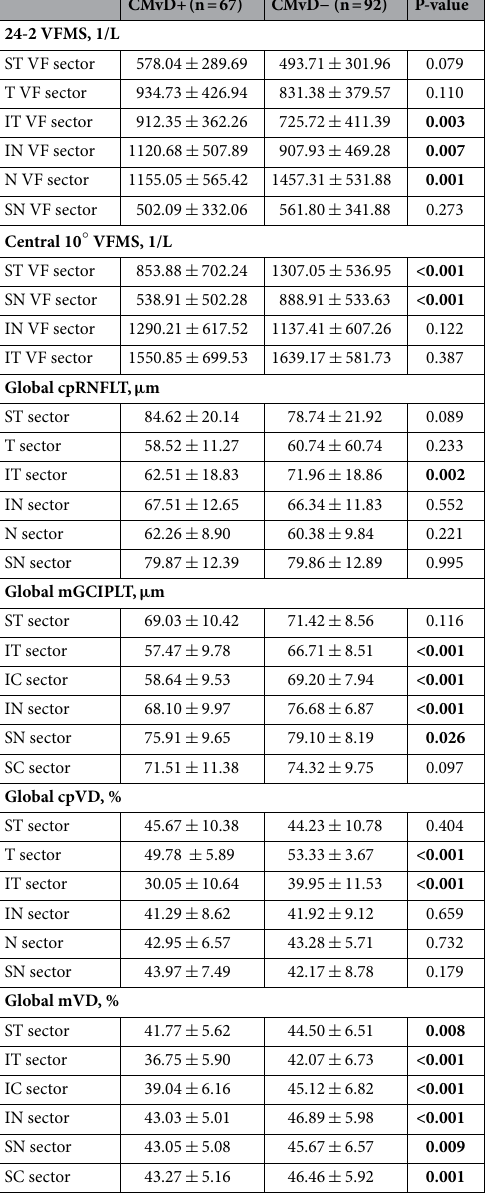
Table 2. Sectoral quantitative comparison of OCT/OCT-A and VFMS data between open-angle glaucoma eyes with and without choroidal microvasculature dropout. CMvD choroidal microvasculature dropout, layer thickness, MS mean sensitivity, mVD macular vessel density, N nasal, OCT optical coherence tomography, OCT-A optical coherence tomography angiography, SC superocenter, SN superonasal, ST superotemporal, T temporal, VF visual field, VFMS visual field mean sensitivity. Significant values are in